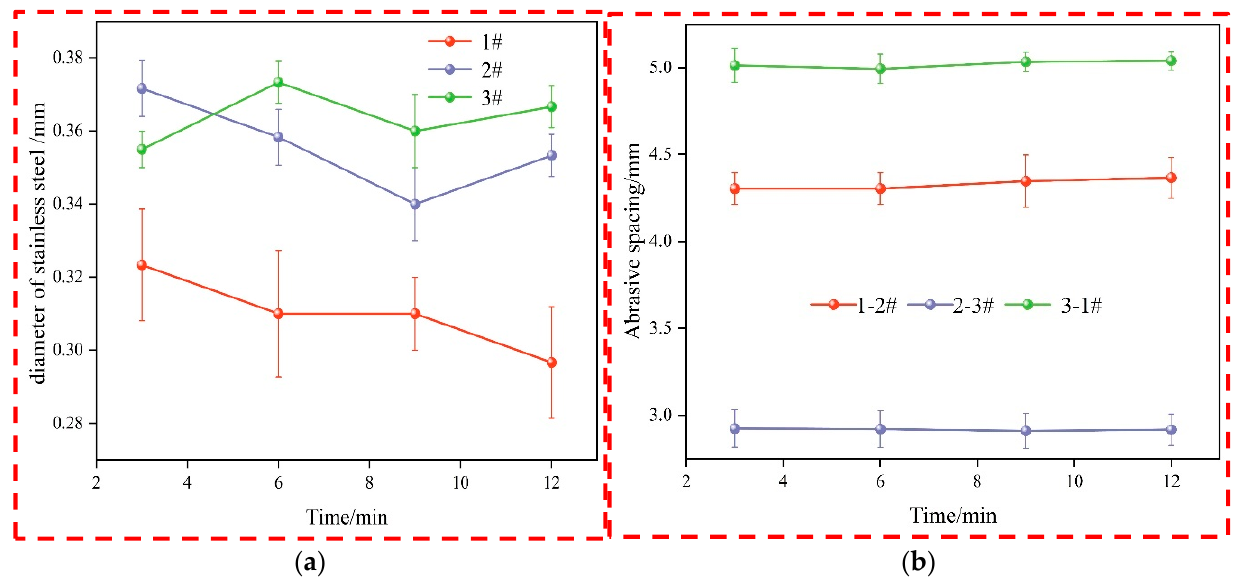
Figure 11. Abrasive particle size and particle spacing after wear. ( a ) Change in abrasive particle diameter. ( b ) Change in abrasive particle spacing.